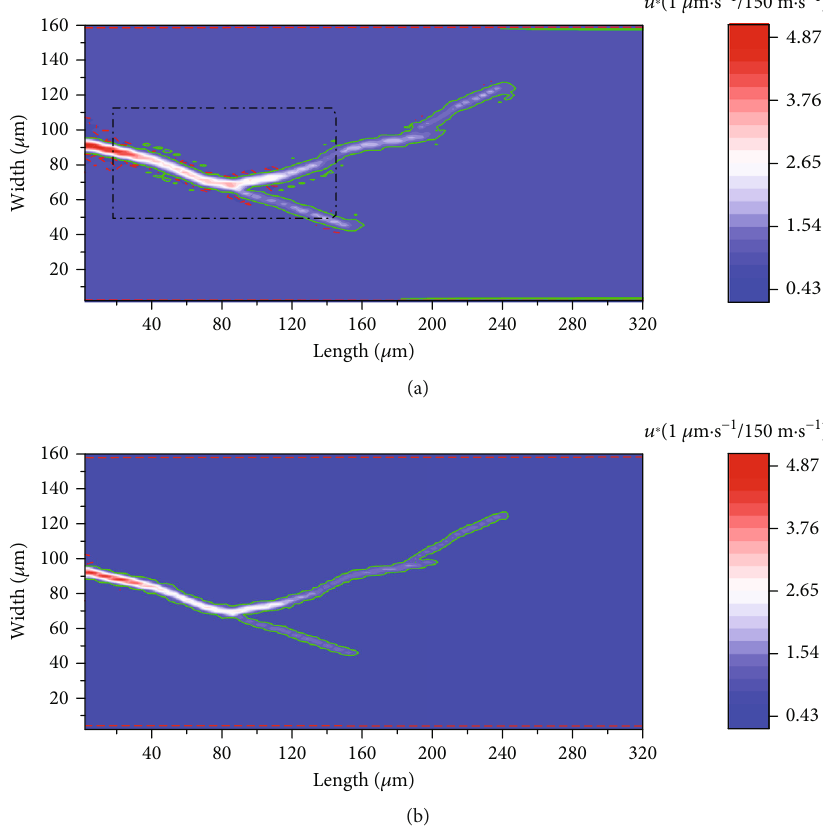
Figure 10: Velocity distribution colormap: (a) original coarse algorithm result; (b) re fi nement algorithm